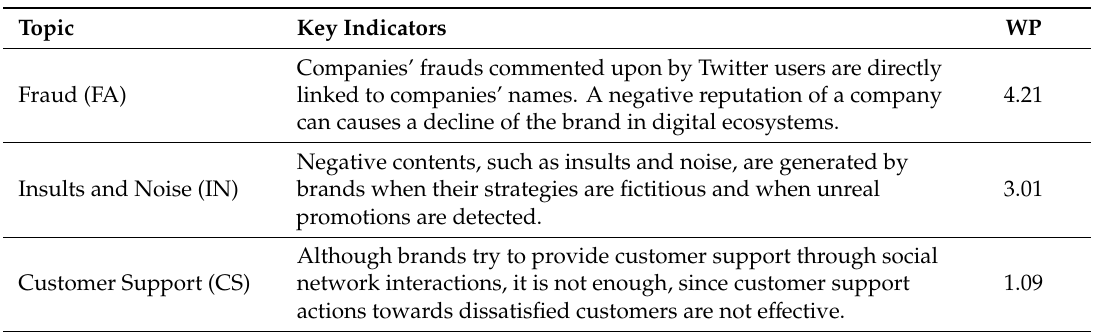
Table 6. TA indicators of negative topics.